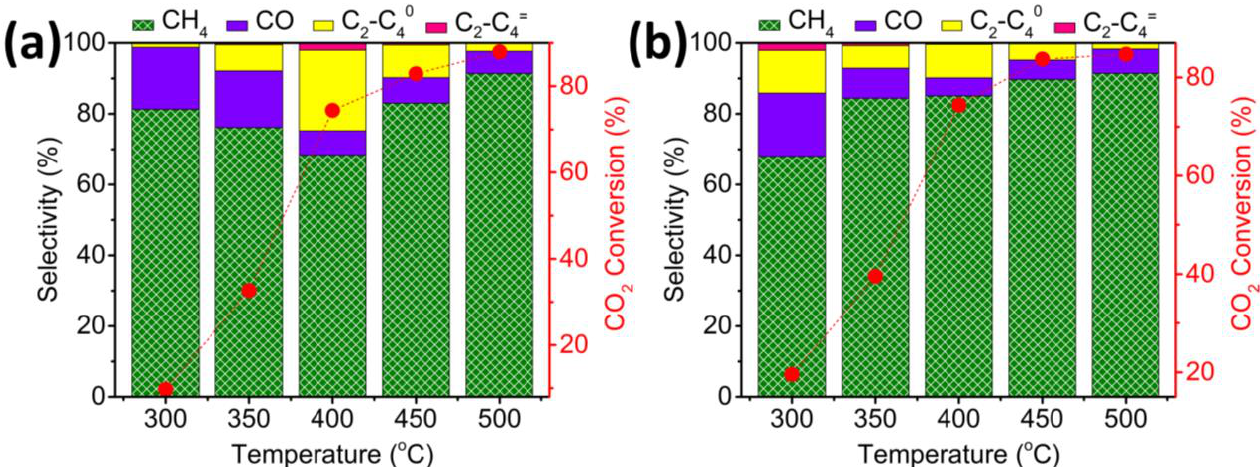
Figure 4. CO 2 conversion and selectivity for samples 1 and 2 at different temperatures. ( a ): Sample 1 and ( b ): sample 2. Reaction condition: H 2 /CO 2 ratio of 7, total flow 4 mL/min, 10 bar, 40 mg catalyst. The error of the measurements is lower than 10%.